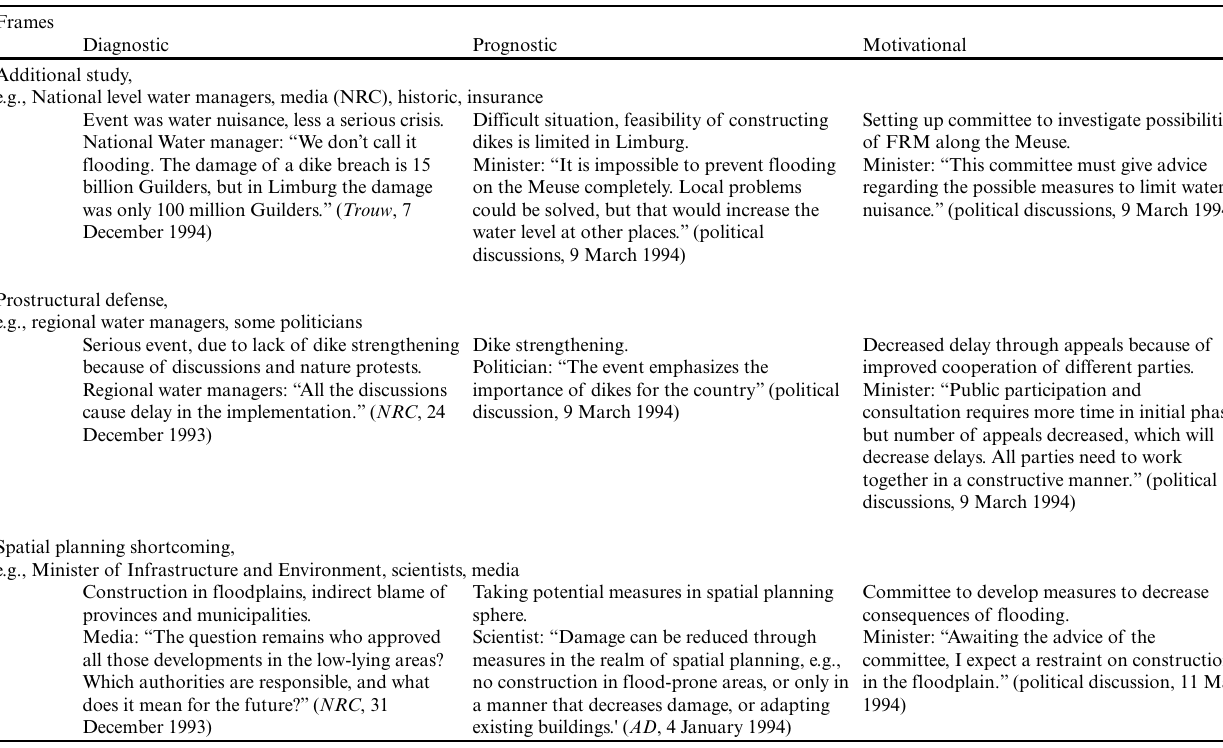
Table 4 . Overview of frames identified after the flood of 1993 with representative quotations (1993–1995). FRM = flood risk